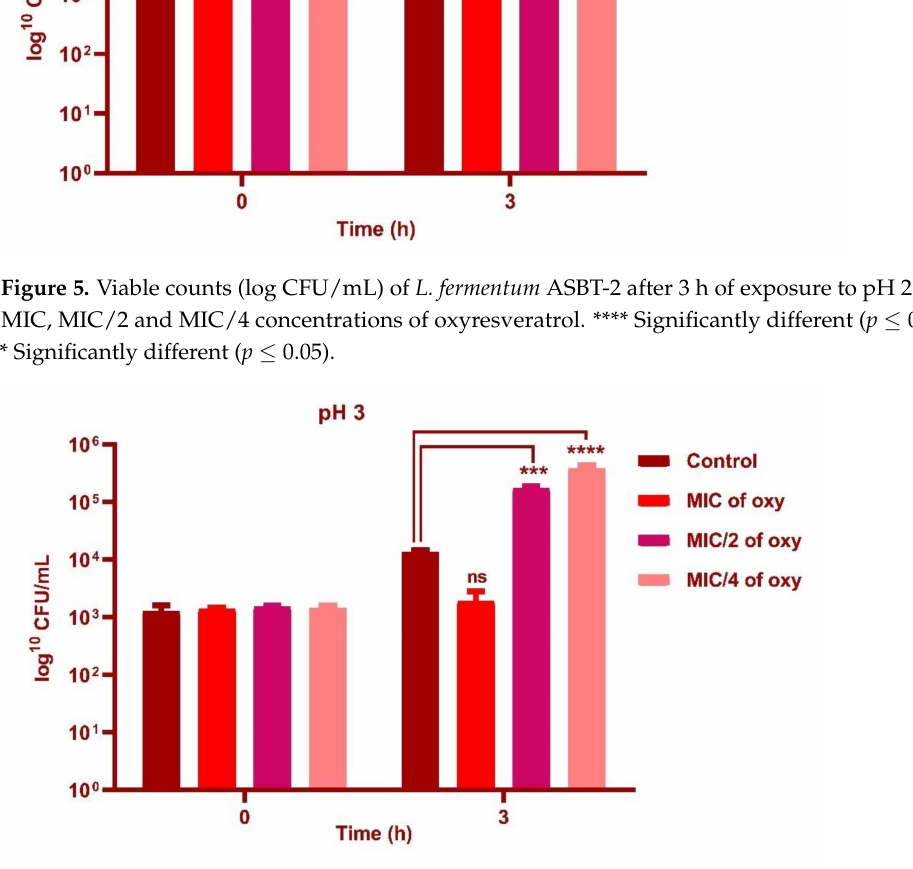
Figure 6. Viable counts (log CFU/mL) of L. fermentum ASBT-2 after 3 h of exposure to pH 3.0 with MIC, MIC/2 and MIC/4 concentrations of oxyresveratrol. **** Significantly different ( p ≤ 0.0001), *** Significantly different p ≤ 0.001, ns: